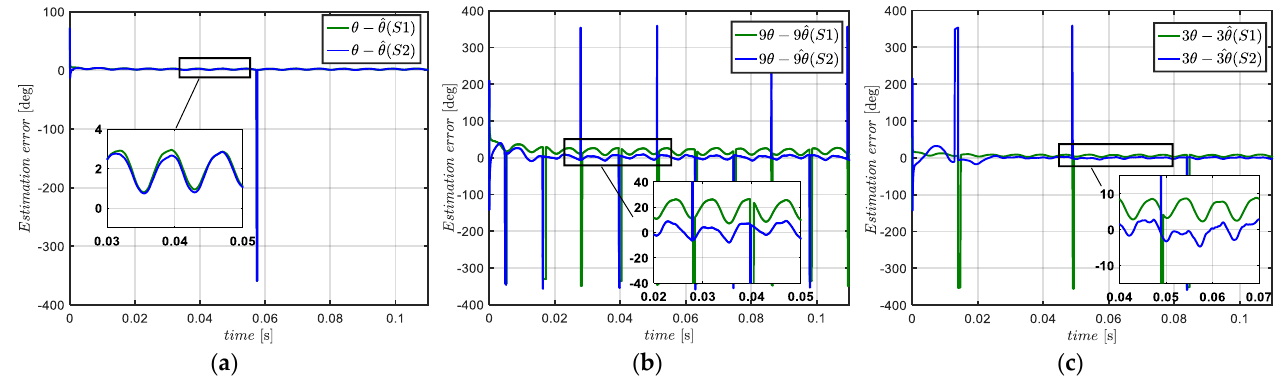
Figure 16. Simulation waveforms of resulting position errors (electrical angle) through ( S1 ) and ( S2 ): ( a ) error on the angle required to control MM, ( b ) error on the angle required to control SM, ( c ) error on the angle required to control TM. Table 3. Resulting position error (electrical angle) from strategies ( S1 ) and ( S2 ) .